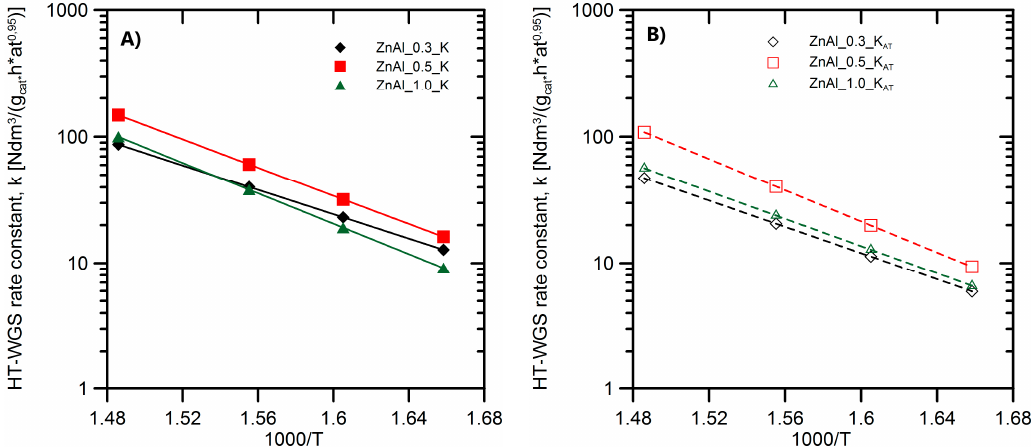
Figure 8. Arrhenius plots for high-temperature water–gas shift (HT-WGS) on ZnAl_X_K ( A ) and on ZnAl_X_K AT catalysts ( B ) at 330, 350, 370, and 400 °C.